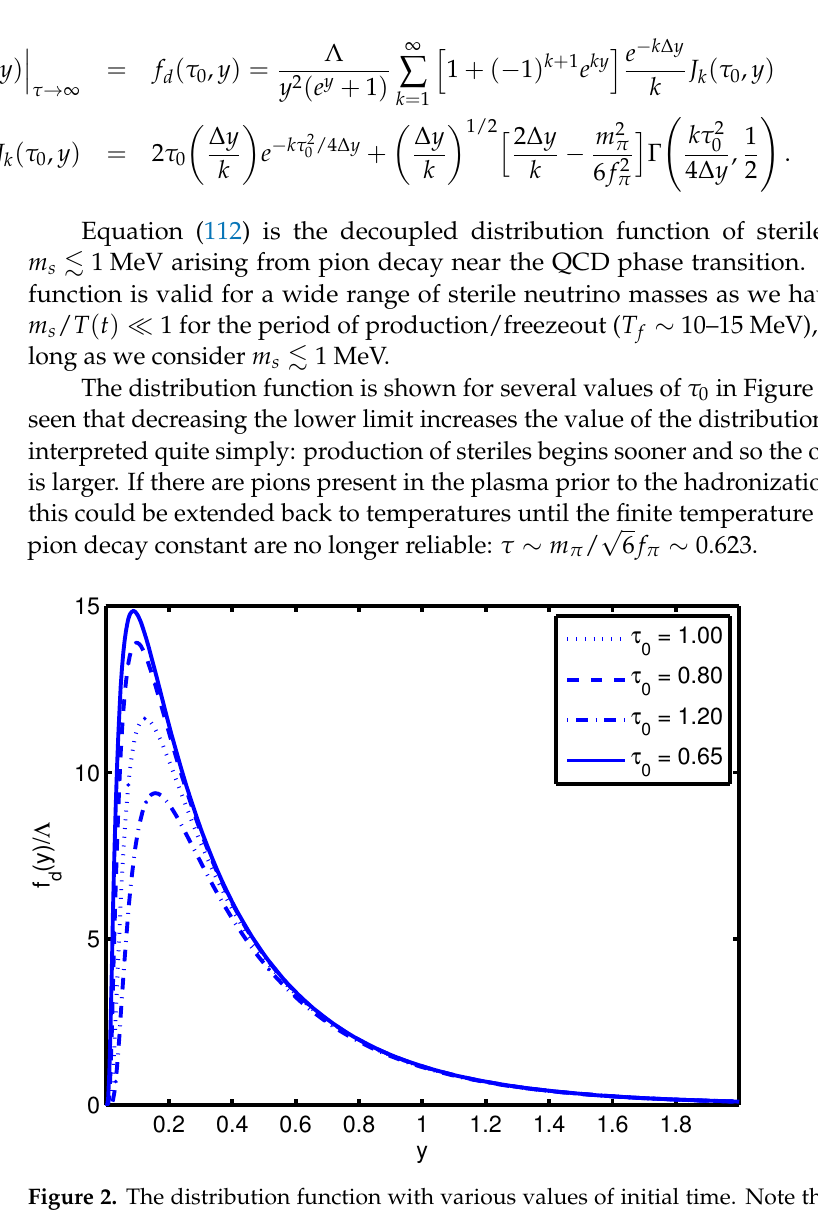
Figure 2. The distribution function with various values of initial time. Note that an earlier initial time provides an enhancement with respect to later